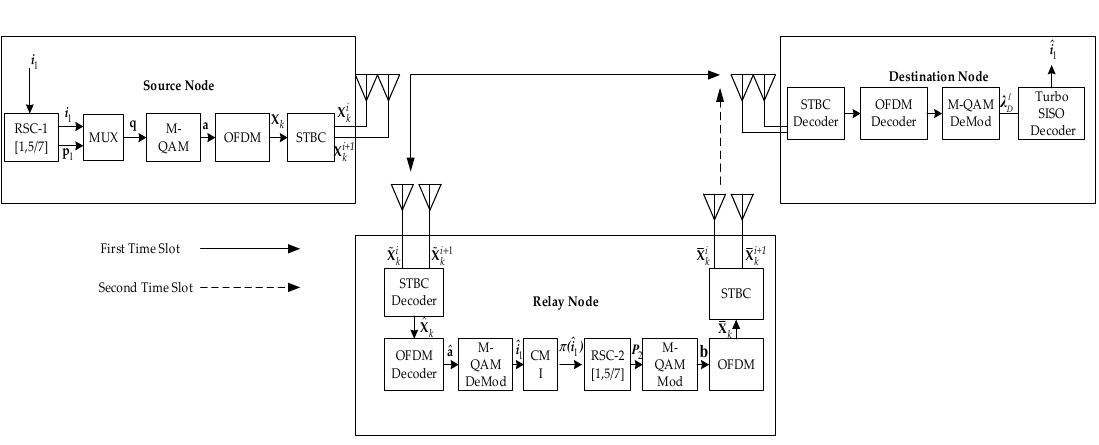
Figure 5 . Distributed turbo coded OFDM with MIMO (2 × 2) antennas. Figure 5. Distributed turbo coded OFDM with MIMO (2 × 2)